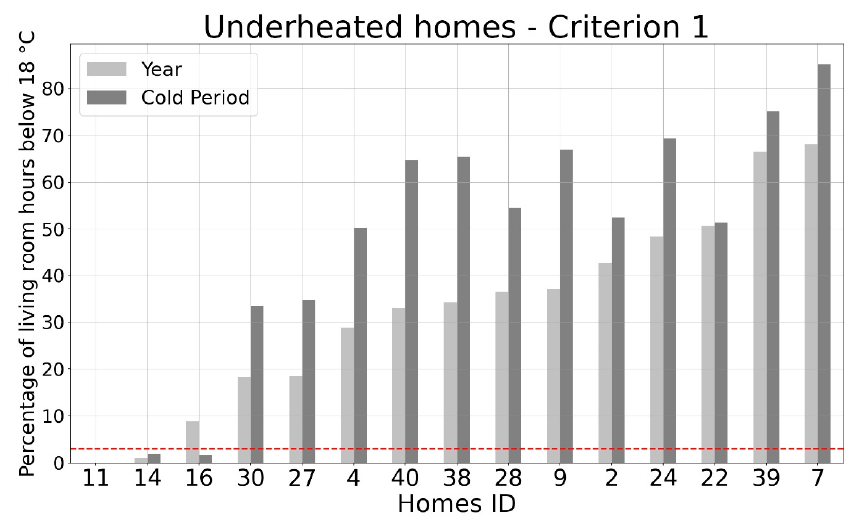
Figure 9. Percentage of underheated hours according to criterion 1.